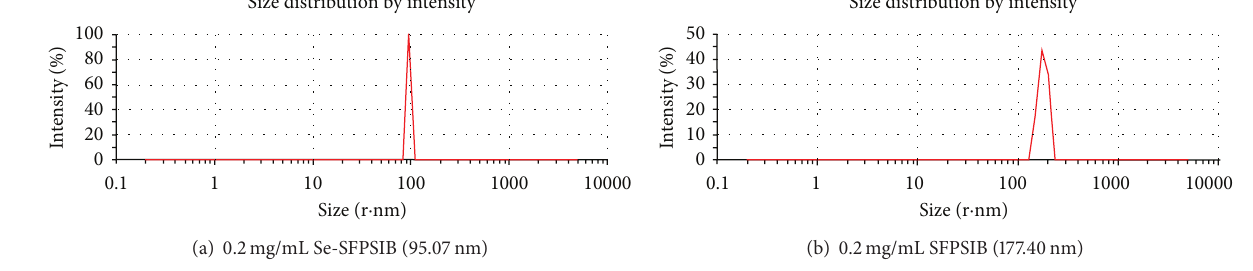
Figure 3: Particle size distribution curves recorded for Se-SFPSIB and SFPSIB.